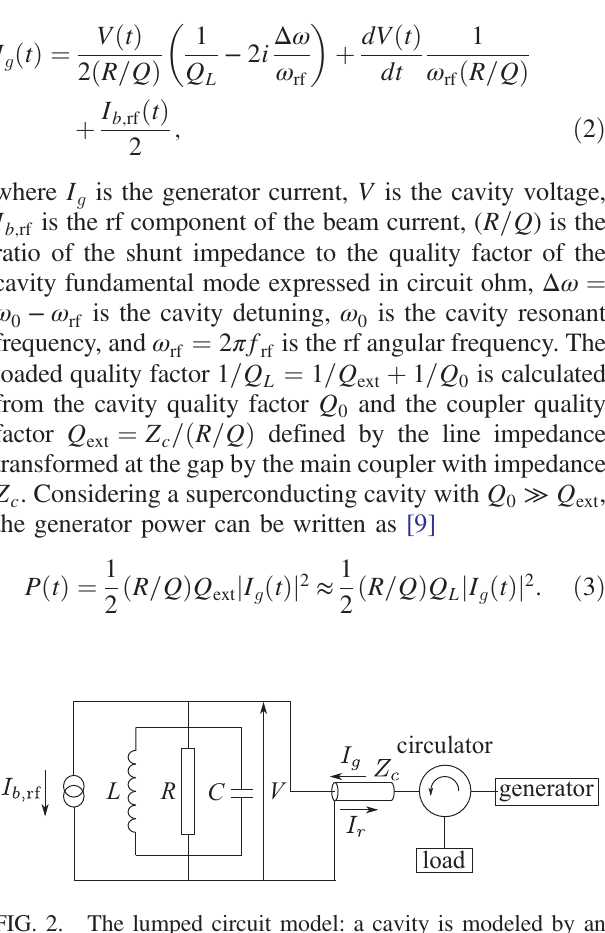
FIG. 2. The lumped circuit model: a cavity is modeled by an LCR block, the coupler by a connected transmission line of impedance Z , and the beam by a current source. I is the rf c b; rf component of the beam current, I is the generator current, and I g r is the reflected current, which is absorbed in the matched load (the generator is connected to the cavity via a